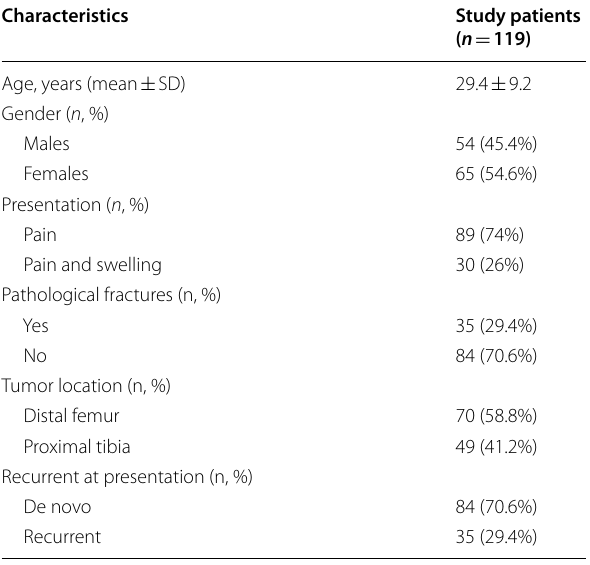
Table 1 Baseline and demographic data for the included patients